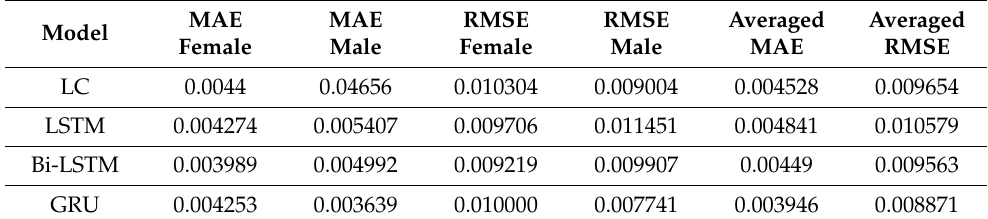
Table 8. The averaged MAE and RMSE values for the models by genders.